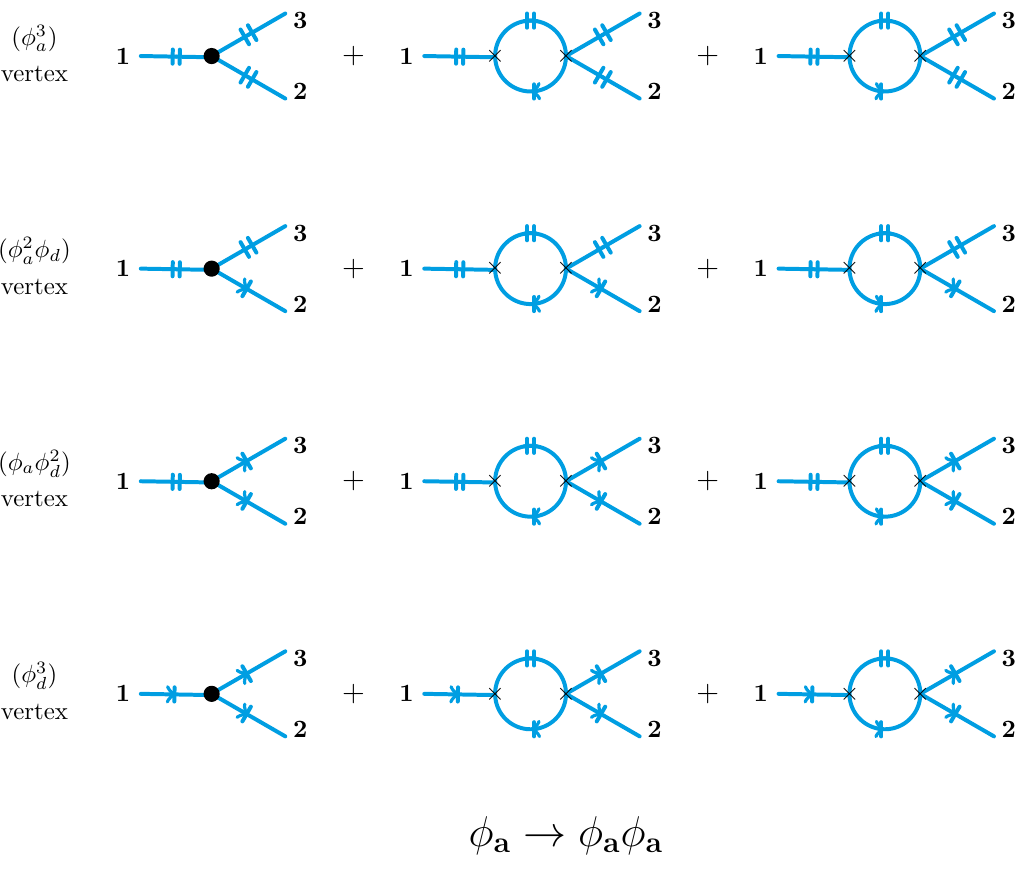
Figure 35. Renormalization of the cubic couplings in the average-di(cid:11)erence